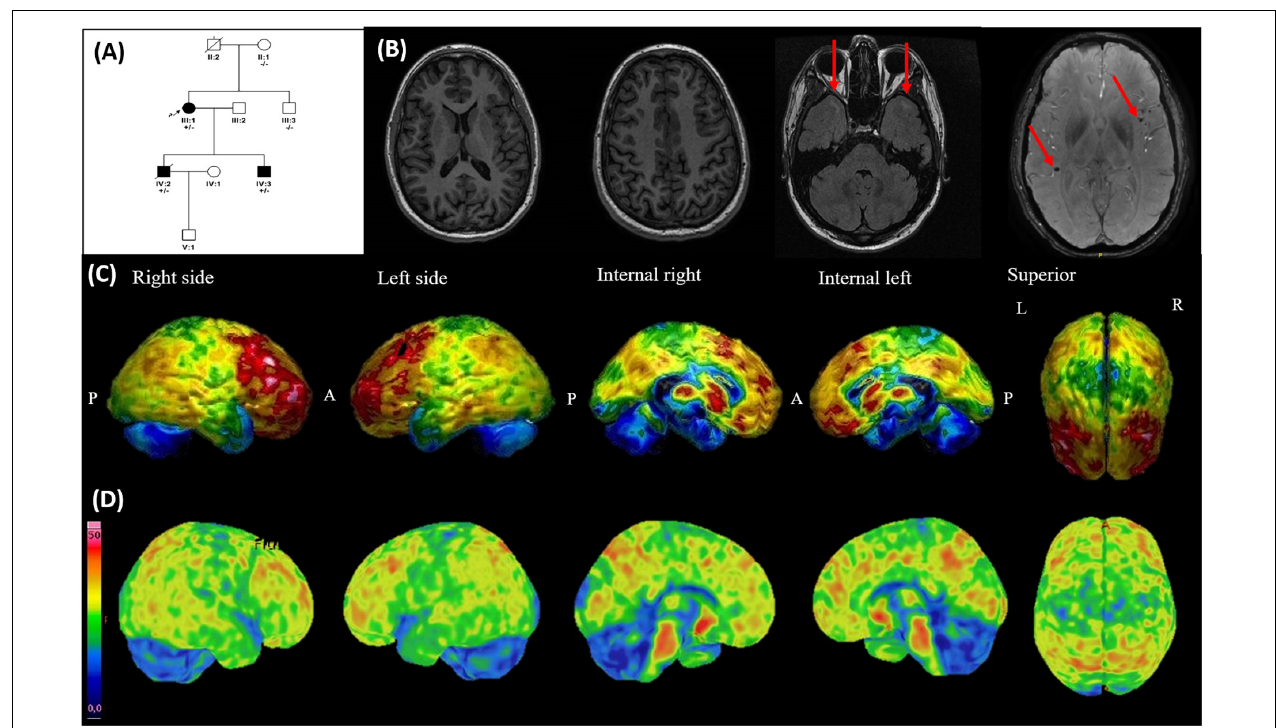
FIGURE 2 | Family 2 pedigree, brain MRI, 18F-fludeoxyglucose PET (FDG-PET), and 18F-flutemetamol PET-TC. (A) Family pedigree: parents of the proband were unaffected, suggesting a de novo mutation. The arrow points to the proband. Dark symbols represent affected individuals. (B) Brain MRI of patient IV.2 at his 34 years old (6 years after disease onset). Left: two axial T1 images showing unspecific mild global cortical atrophy. Middle: axial FLAIR image, which reveals subcortical focal white-matter hyperintensities in the anterior temporal lobe (red arrows). Right: susceptibility-weighted (SW) image showing two microbleeds (red arrows). (C) FDG-PET of patient IV.3 shows bilateral hypometabolism in anterior temporal lobes, pre- and post-central gyri, and cerebellum. Colder colors represent lower glucose uptake. P, posterior; A, anterior; L, left; R, right. (D) 18F-flutemetamol PET of patient IV.3 shows diffusely increased amyloid binding in parietal and frontal lobes, sparing anterior temporal lobes, pre- and post-central gyri, and cerebellum. Colder colors represent lower amyloid